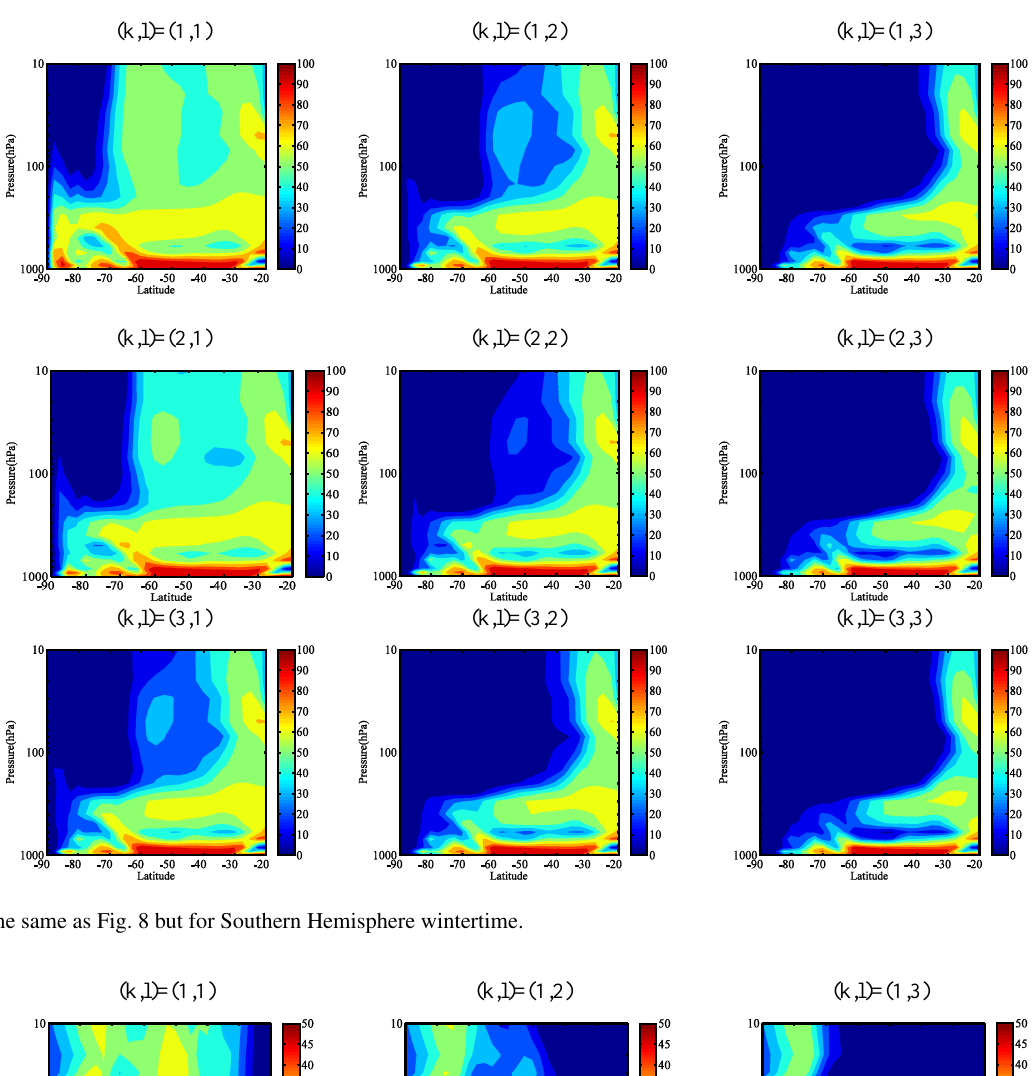
Figure 9. The same as Fig. 8 but for Southern Hemisphere wintertime.